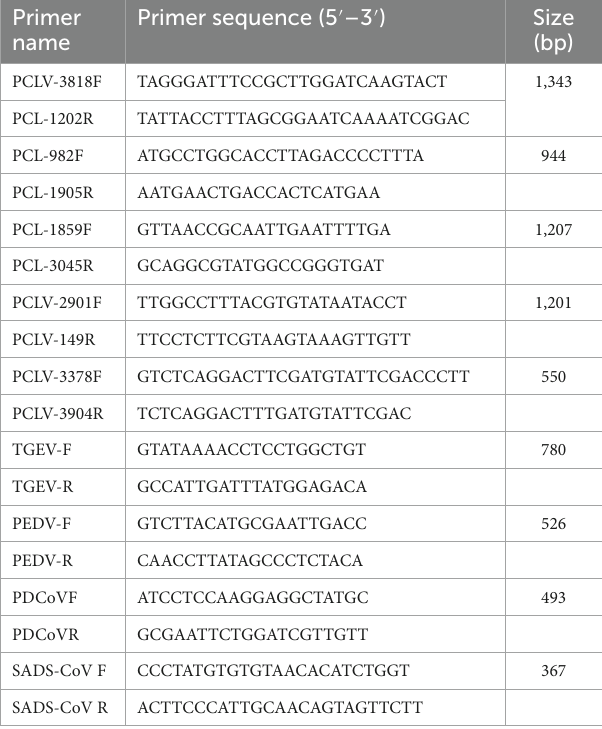
TABLE 1 List of primer sequences used in this